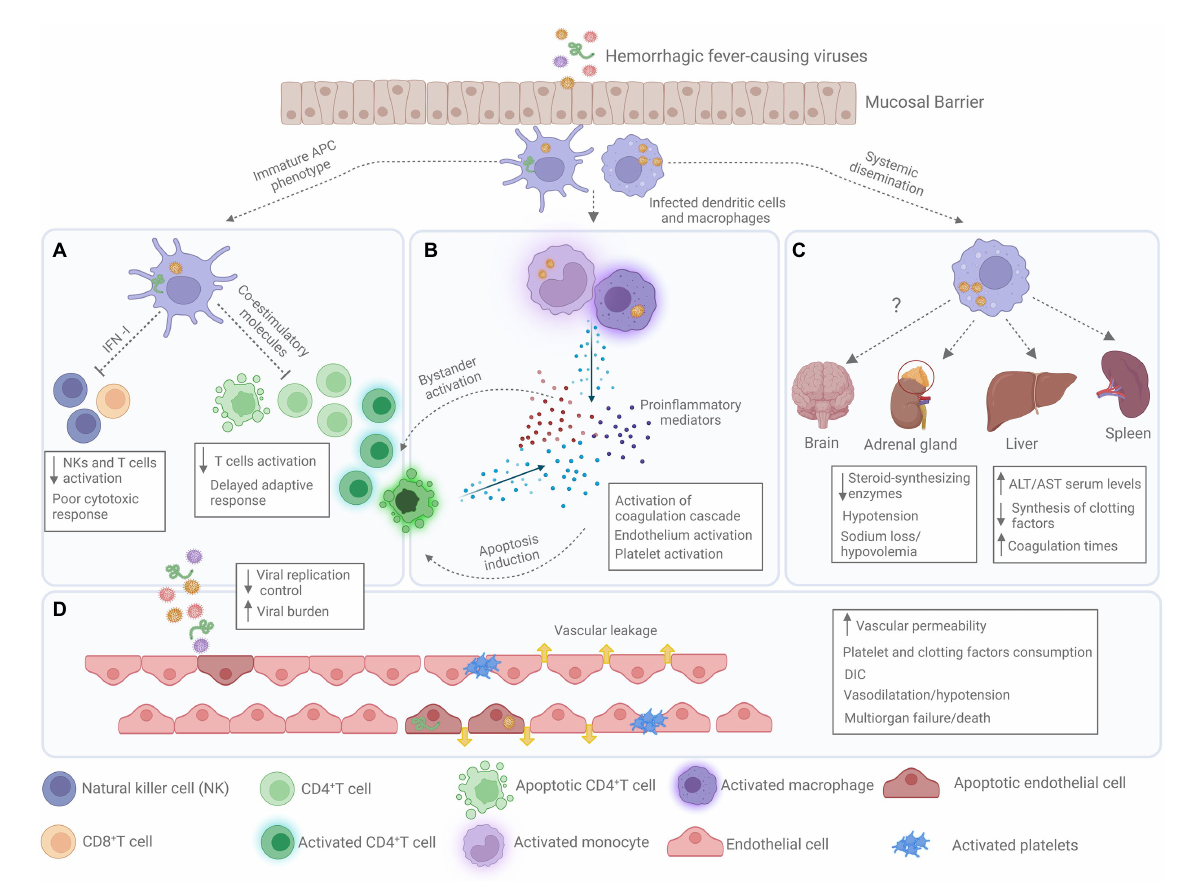
FIGURE 1 Pathogenesis of severe viral hemorrhagic fever. (A) Antigen presenting cells (APCs) present an immature phenotype with low expression of co- stimulatory molecules and low type I interferon (IFN-I) production, leading to poor NK and T cells activation causing a generalized immunosuppression, which lead to uncontrolled viral replication and high viral burdens. (B) During the infection monocytes and macrophages produced large quantities of proinflammatory mediators causing the phenomenon known as cytokine storm. These proinflammatory mediators cause endothelial and platelet activation and induce bystander activation and apoptosis of T cells. (C) Infected APC transport Hemorrhagic fever viruses (HFVs) to lymph nodes and other organs causing a systemic dissemination. Infection of some organs such as liver and adrenal gland results in high serum levels of hepatic enzymes (aspartate amino transferase-AST, and alanine amino transferase-ALT), low production of clotting factors and hypovolemia. (D) Sustained proinflammatory state and viral infection of endothelial cells induce abnormal vascular regulation and organ effusion, hemorrhages, and disseminated intravascular coagulation